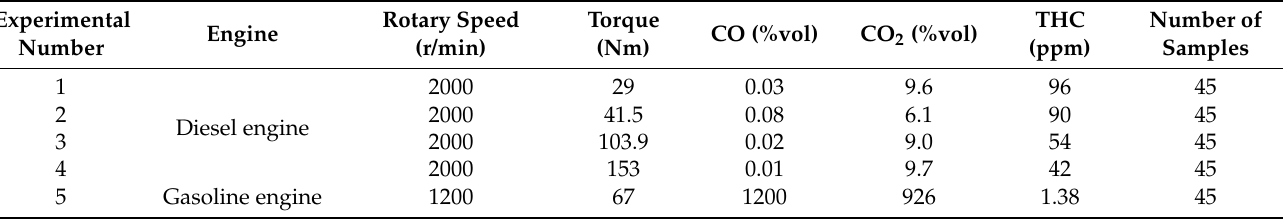
Table 2. Composition of experimental